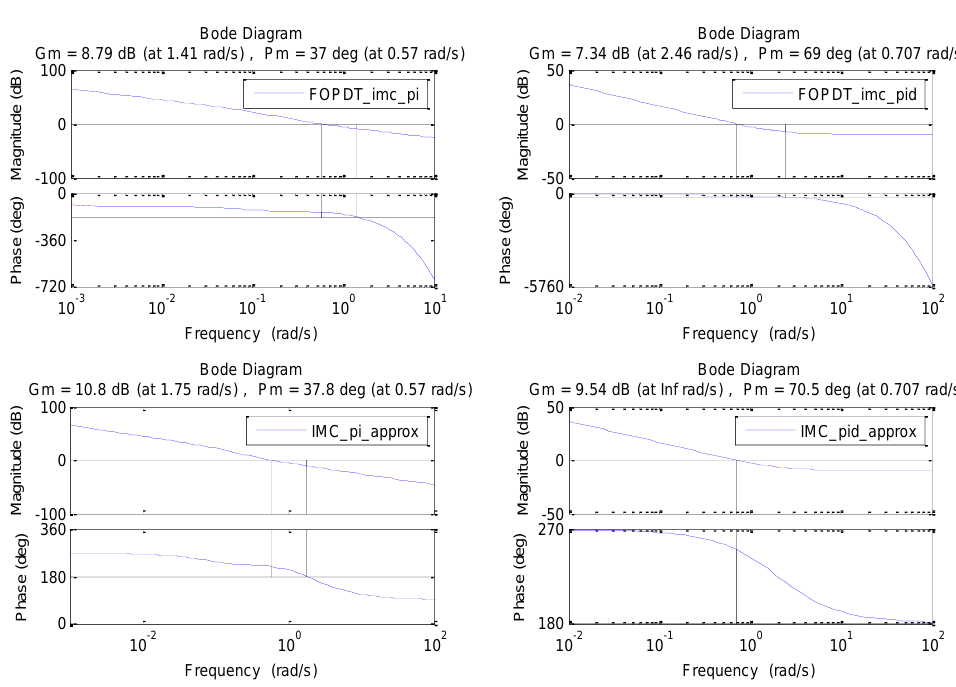
Figure 8. Bode plots of G(s) and G Pade’s (s) with IMC